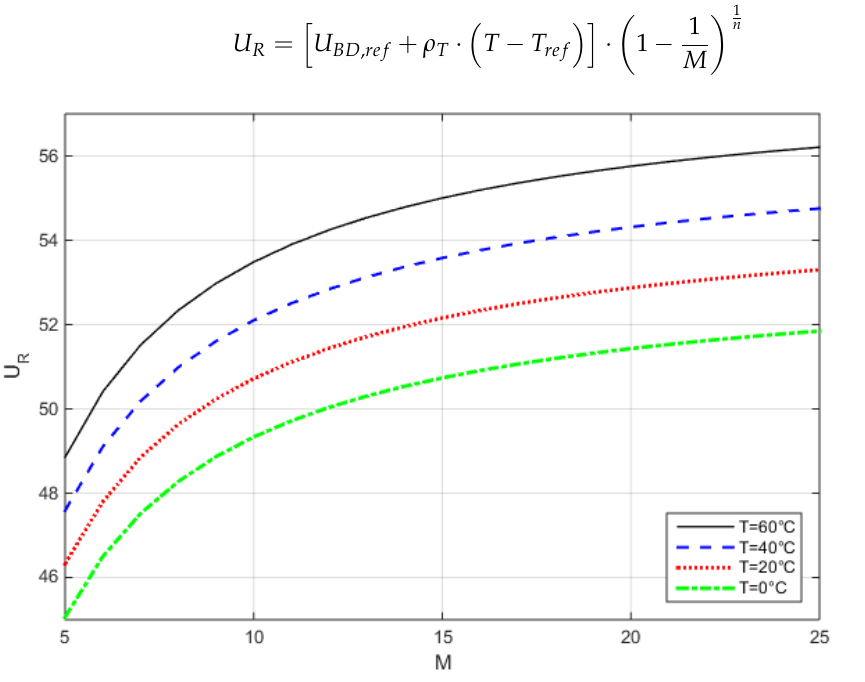
Figure 5. U R (M,T) for U BDref = 55 V at 20 °C, and ρ T = 0.075 V/°C.